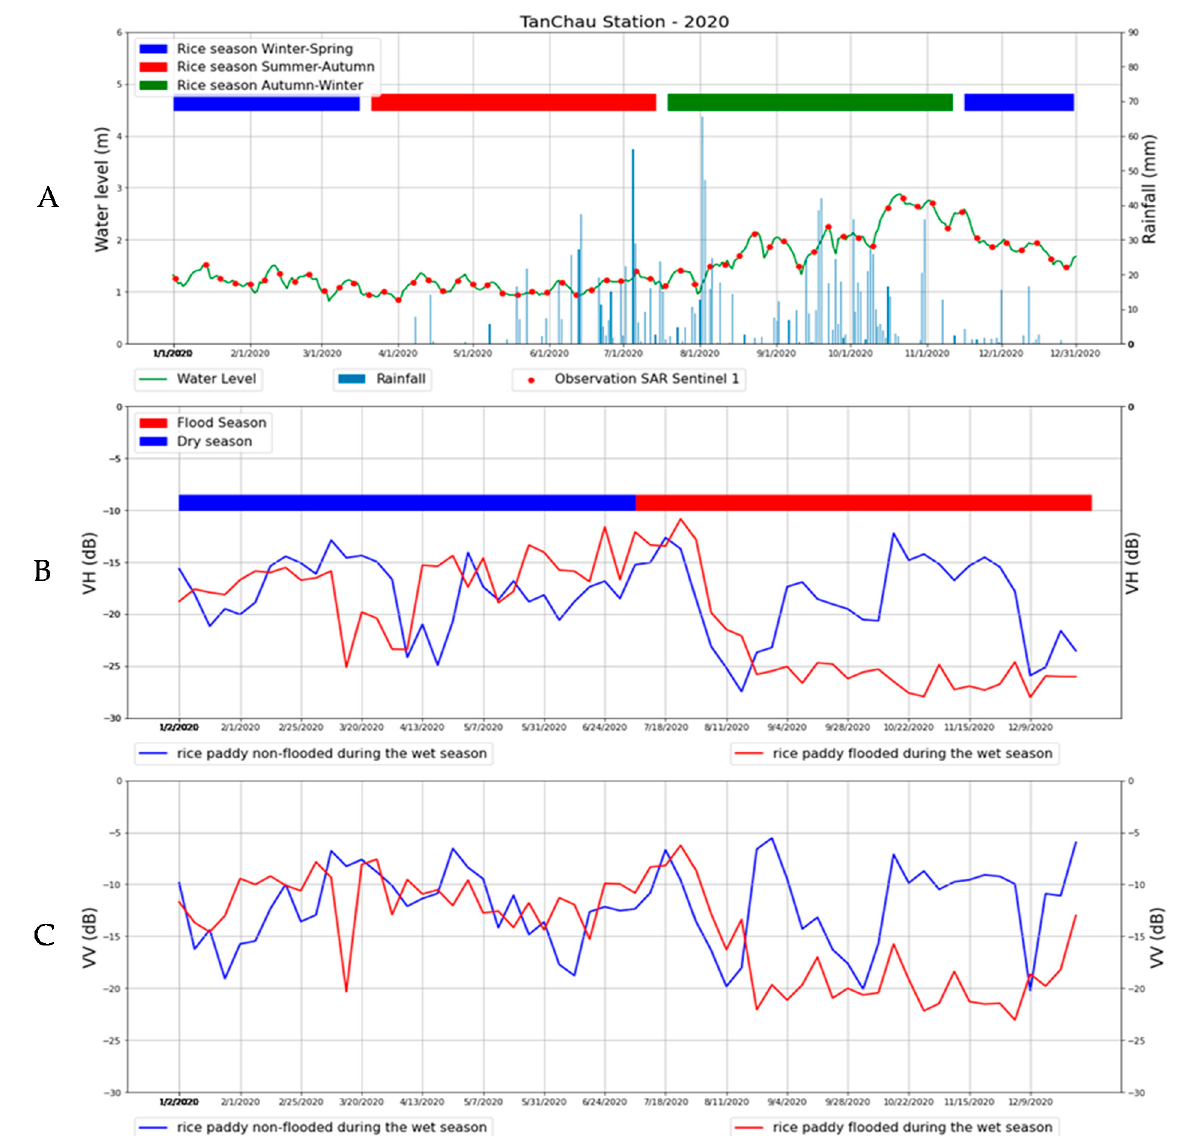
Figure 7. ( A ) Daily rainfall and daily water levels of the Mekong River recorded at the Tan Chau hydro-meteorological station during 2020. Seasons of the three rice cycles (rice season winter-spring, summer-autumn and autumn-winter). Observations of SAR Sentinel-1: 60 images for 2020; ( B ) Temporal VH profiles of non-flooded rice paddies during the wet season and of flooded rice paddies during the wet season; ( C ) Temporal VV profiles of non-flooded rice paddies during the wet season and of flooded rice paddies during the wet season.